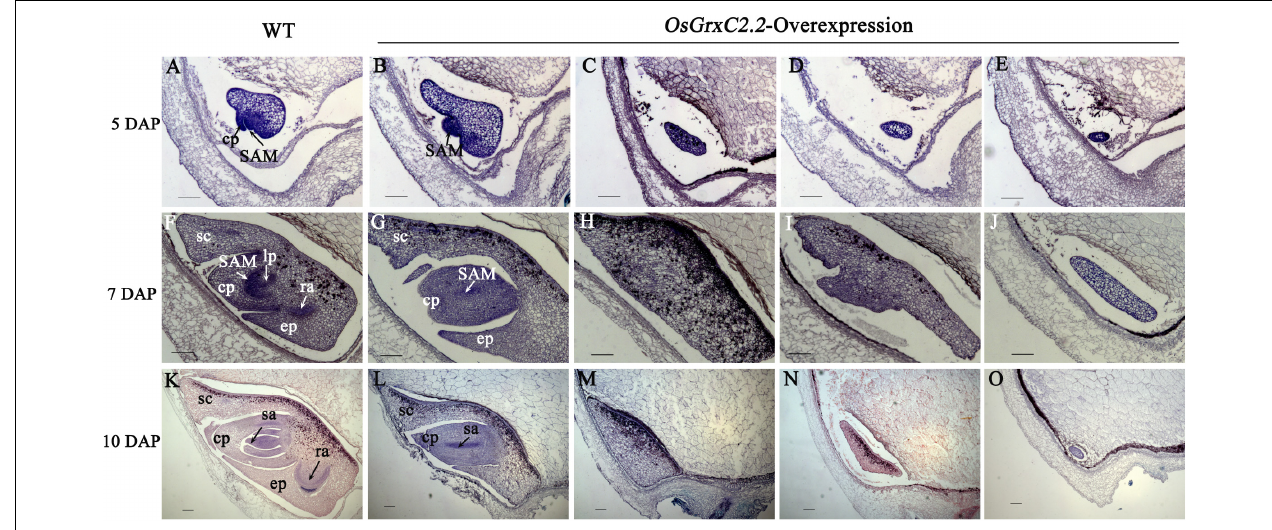
FIGURE 4 | Median longitudinal sections of WT and OsGrxC2.2 -overexpression lines embryos at various developmental stages. Developing embryos of WT (A,F,K) and representative overexpression line OE11 (B–E,G–J,L–O) at 5 DAP (A–E) , 7 DAP (F–J) , and 10 DAP (K–O) . cp, coleoptiles; ep, epiblast; lp, leaf primordium; ra, radical apex; sa, shoot apex; SAM, shoot apical meristem; sc, scutellum are as indicated. Bars = 100 µ m.